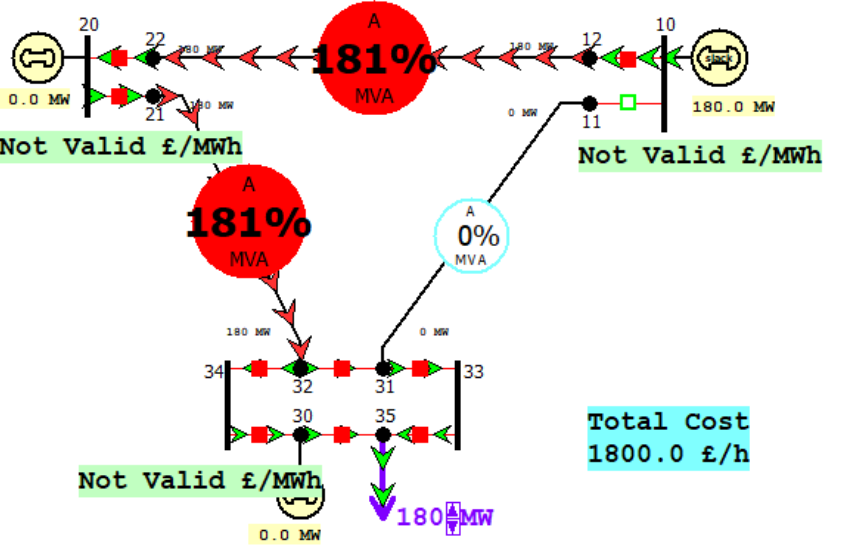
Figure 10. Trip a circuit breaker under attack in a 12-bus system.